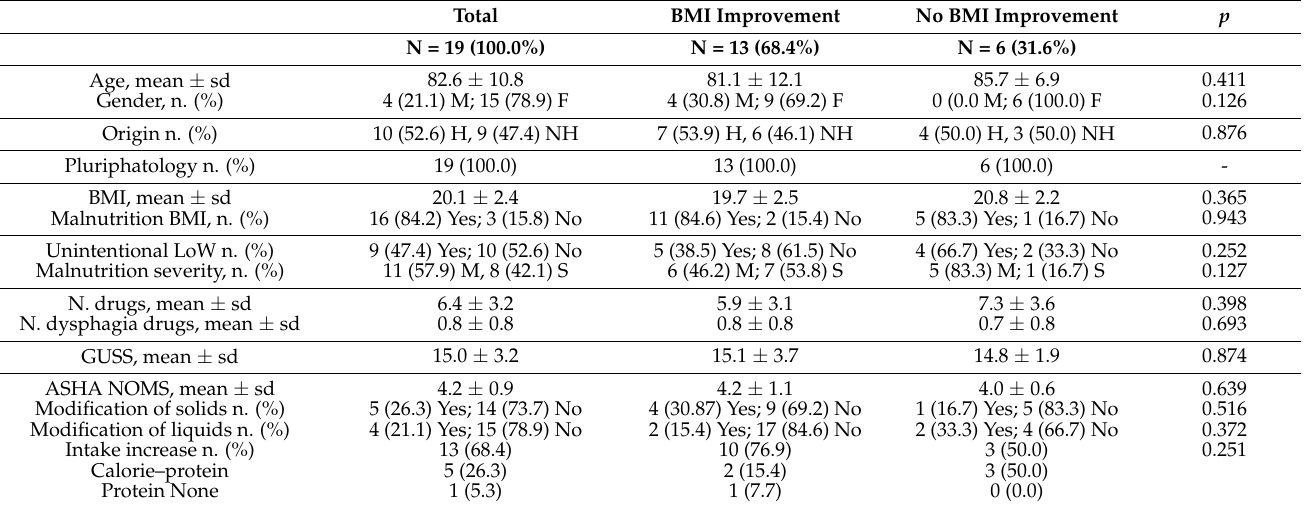
Table 5. Descriptive analysis of sociodemographic, functional and clinical parameters, and BMI improvement in dysphagic subjects diagnosed as malnourished during the first visit (relative fre- quencies, mean values) ± SD); absolute and relative frequencies